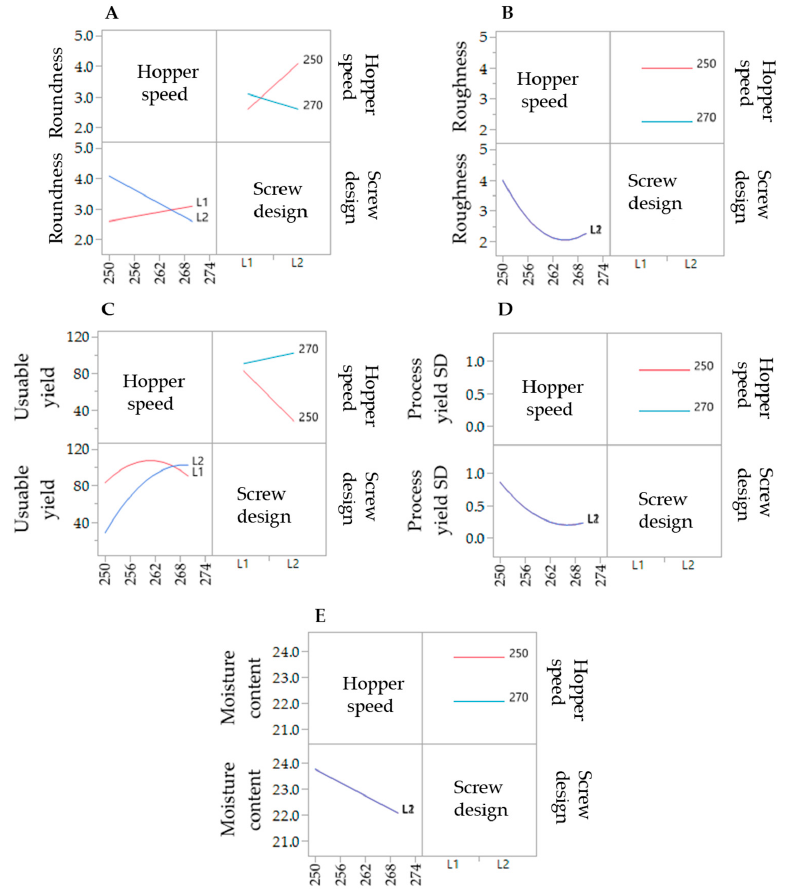
Figure 5. Interaction profiles of the extrusion process variables hopper speed and screw design on the responses roundness ( A ), roughness ( B ), useable yield ( C ), process yield SD ( D ) and moisture content ( E ).